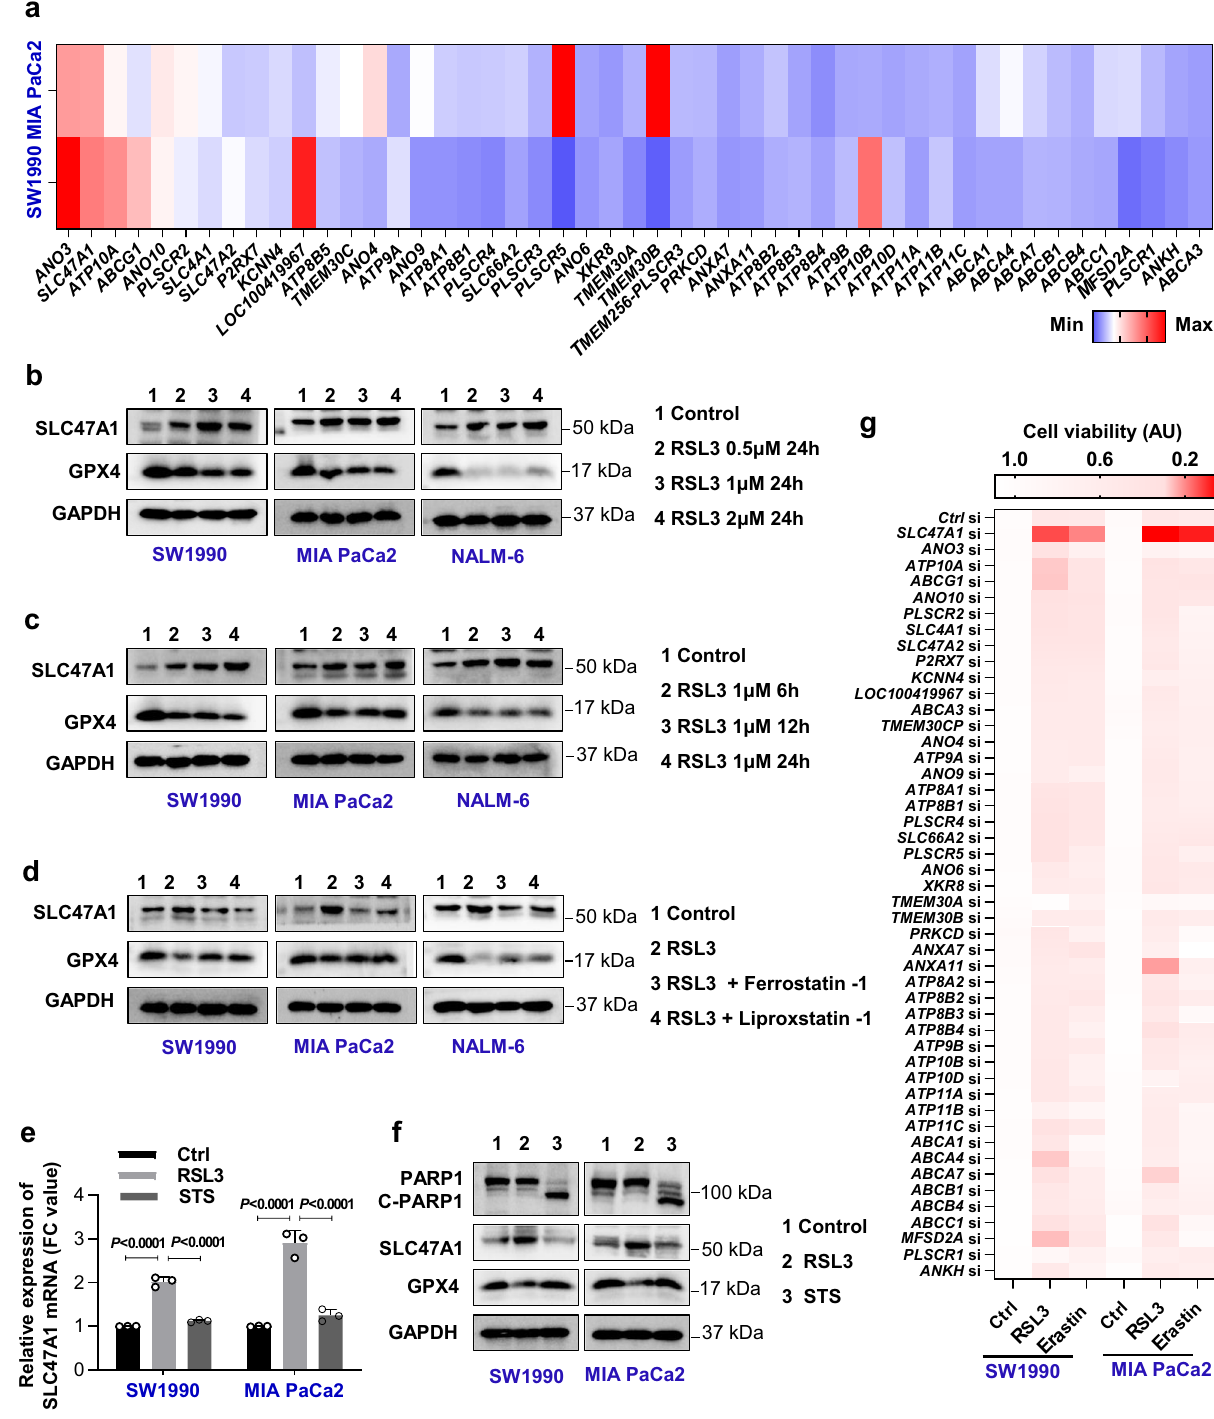
Fig. 1 | SLC47A1 is upregulated during ferroptosis. a Relative mRNA change of phospholipidtransportersinindicatedhumanPDACcellsfollowingtreatmentwith RSL3 (1 μ M) for 24h. b Western blot analysis of protein expression in indicated cells following treatment with RSL3 (0.5 – 2 μ M) for 24h. c Western blot analysisof protein expression in indicated cells following treatment with RSL3 (1 μ M) for 6 – 24h. d Western blot analysis of protein expression in indicated cells following treatmentwithRSL3(1 μ M)intheabsenceorpresenceofliproxstatin-1(0.5 μ M)or ferrostatin-1 (0.5 μ M) for 24h. e qPCR analysis of SLC47A1 mRNA expression in indicated cells following treatment with RSL3 (1 μ M, 24h) or staurosporine (1 μ M, 12h) ( n =3 biologically independent samples, statistical signi fi cance was analyzed